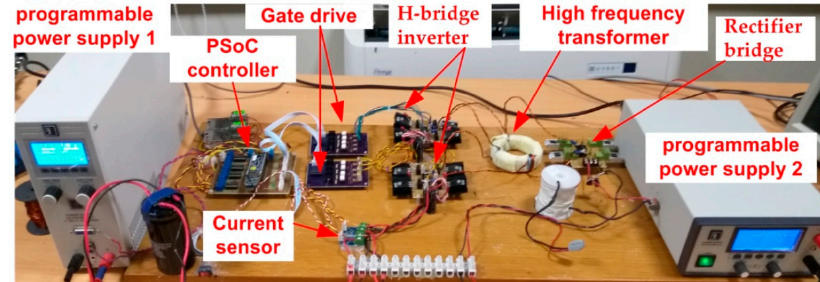
Figure 9. The experimental